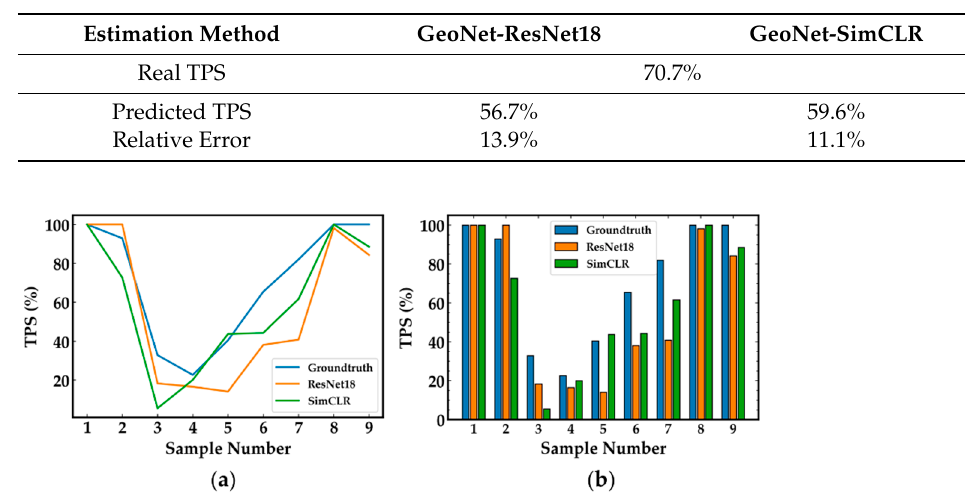
Figure 12. ( a ) TPS value of each image in the unlabelled LUSC set. ( b ) Histogram of ( a ).